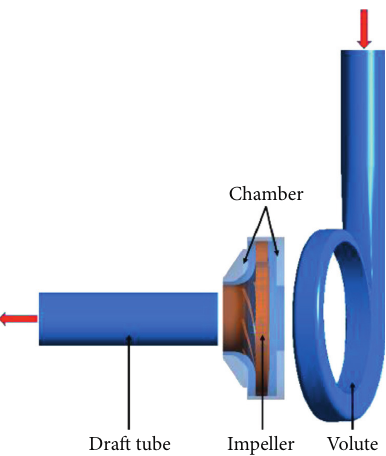
Figure 3: Hydraulic model of